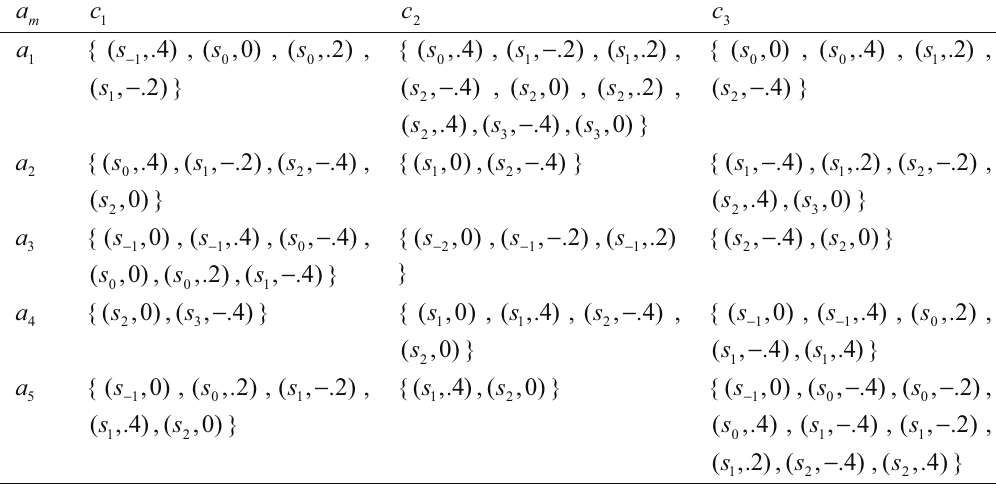
Table 8. The final decision